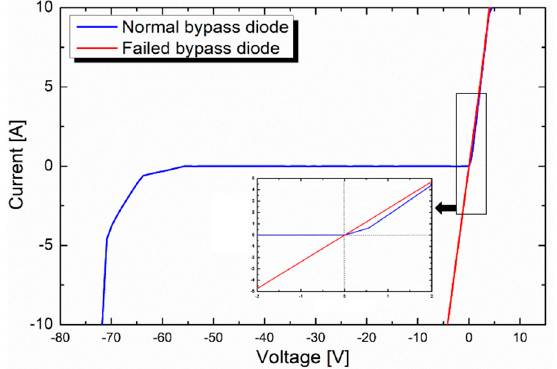
Figure 6. Measured I–V curves of the normal and failed bypass diode.